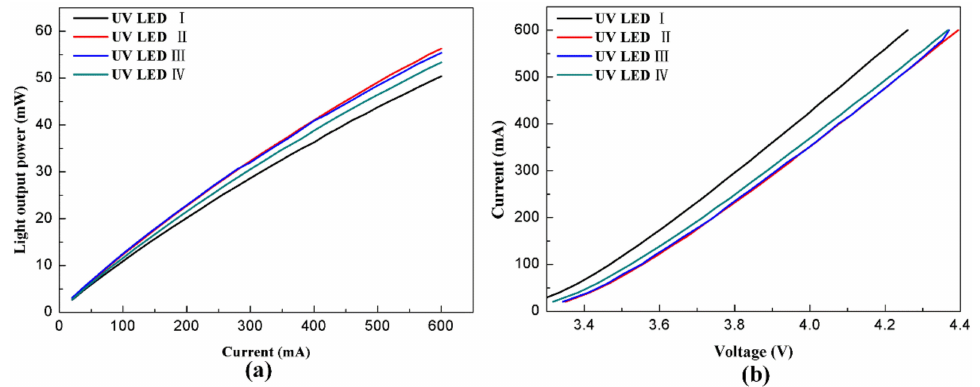
Figure 8. ( a ) L-I characteristic and ( b ) I–V characteristic of UV LED I, UV LED II, UV LED III, and UV LED